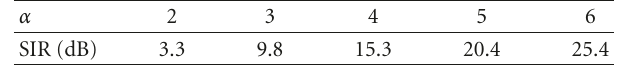
Figure 6: An example of a dual packing formed by a right packing and a left packing. An ellipse corresponds to a PNC unit. The nodes between two adjacent ellipses (including the terminal nodes of the ellipses) are grouped together by a